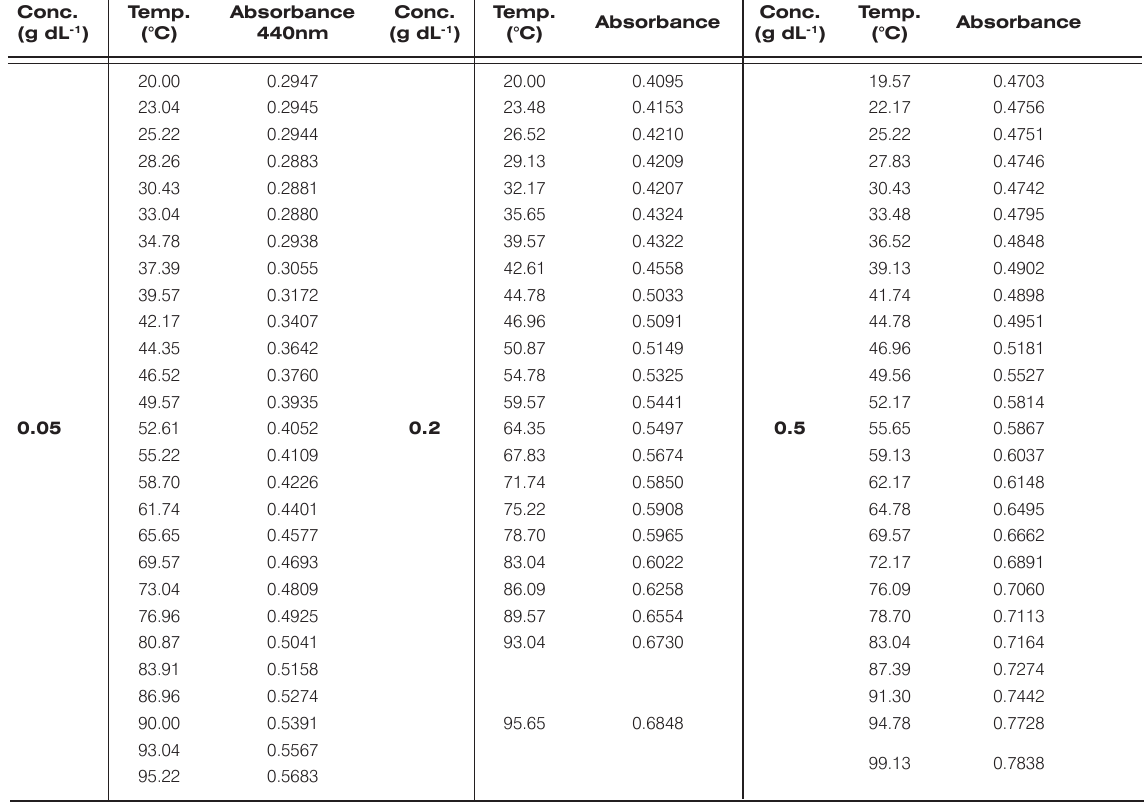
Table 2. Variation of absorbance with concentration and temperature. Conc. Temp. (g dL -1 )